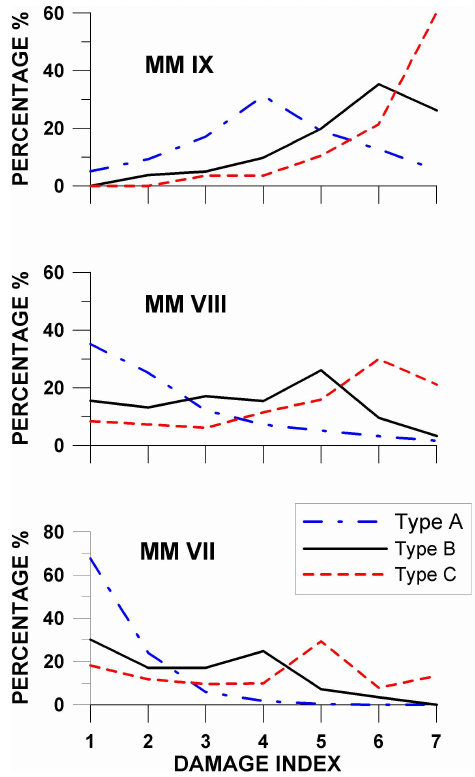
Fig. 5. Curves corresponding to the DPM-2007 for three MM in- tensities (VII, VIII, and IX) and three types of